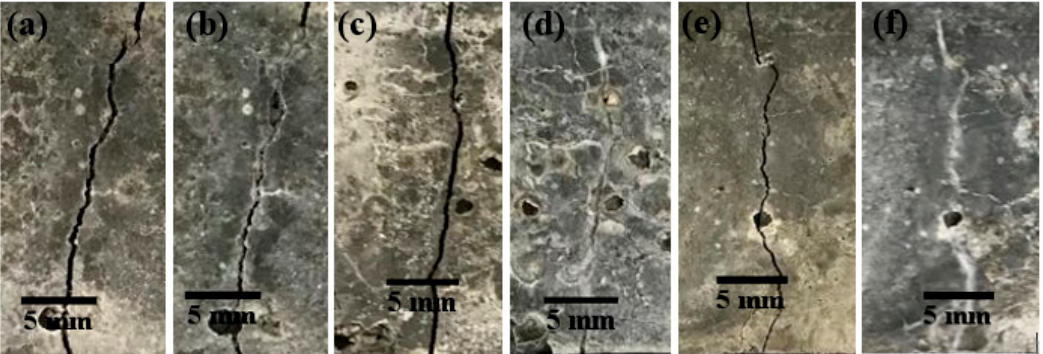
Figure 13. Examples of partially healed cracks after 28 days of wet and dry cycles; ( a , c ) before healing with N and NS2, respectively; ( b , d ) after healing with N and NS2, respectively; Example of complete healing of cracks after 28 days of wet and dry cycles; ( e ) before healing ( f ) after healing with NS1 capsules.